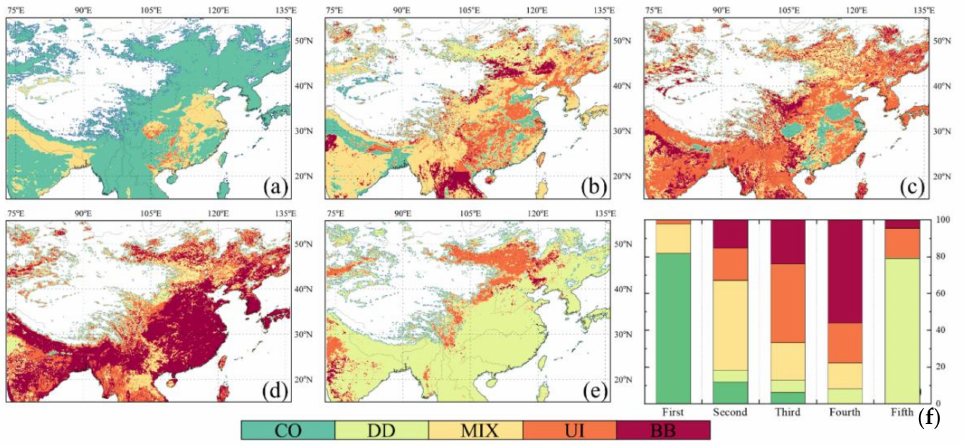
Figure 9. Spatial distribution of ( a ) first, ( b ) second, ( c ) third, ( d ) fourth, and ( e ) fifth dominant aerosol type; ( f ) the total proportion of each type for five dominant conditions based on MODIS